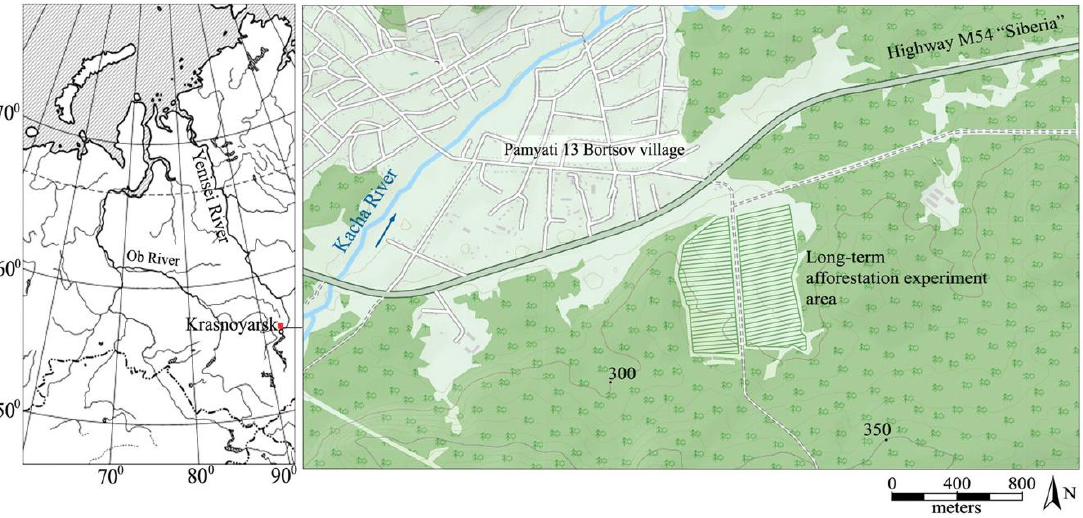
Figure 2. Location and situation plan of study area. The red square on the left is the geographical position of the study area. position of the study